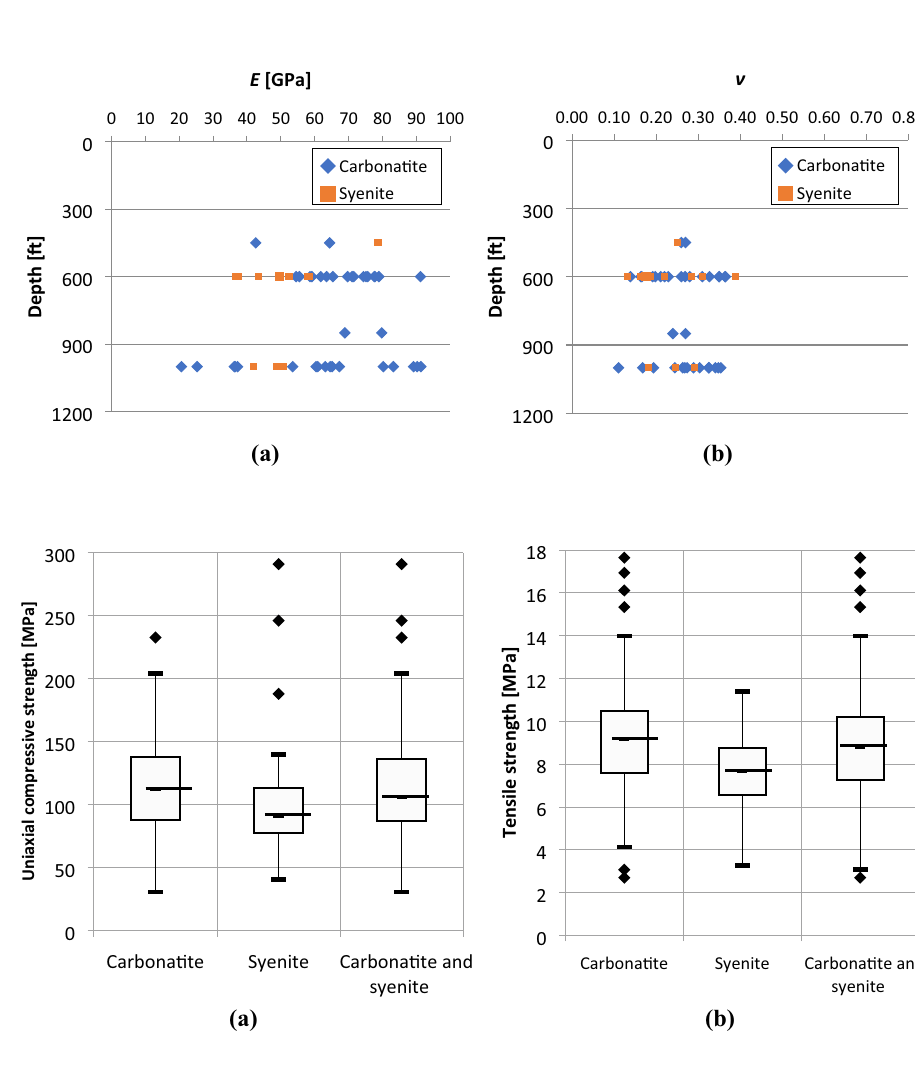
Fig. 2 Distribution of the results as a function of depth for a uniaxial compressive strength b tensile strength